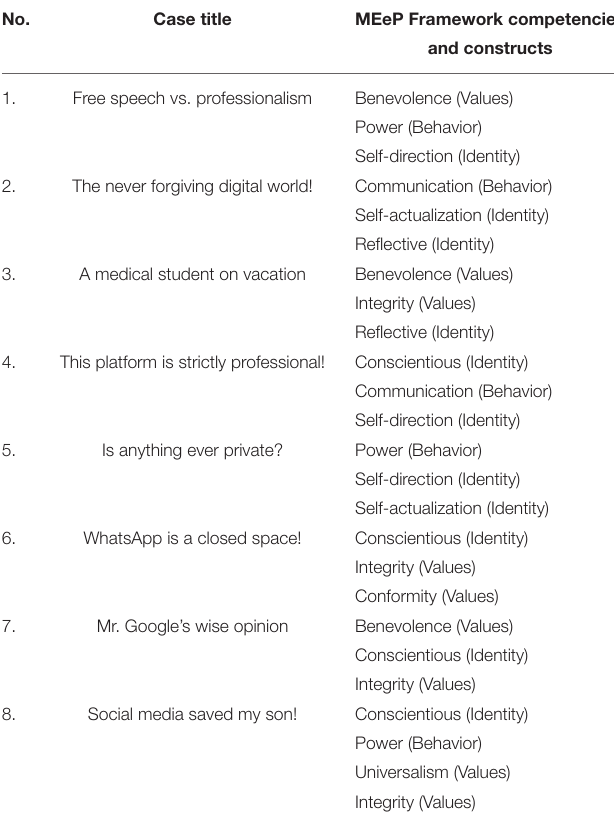
TABLE 1 | Mapping of competencies and constructs of the MEeP framework with eight case scenarios selected the framework evaluation.